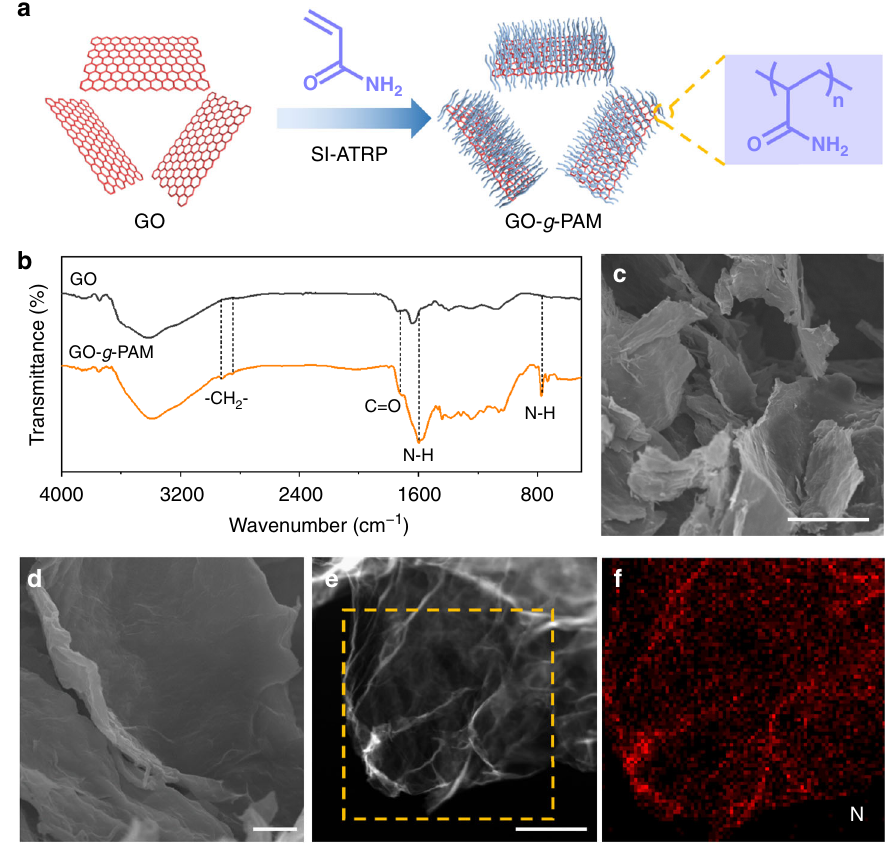
Fig. 2 Characterization of GO- g -PAM molecular brushes. a Schematic illustration of the synthesis of GO- g -PAM molecular brushes: modifying GO nanosheets by α -bromoisobutyryl bromide to introduce Br-containing initiation sites and in situ grafting PAM chains from the modi fi ed surface of GO nanosheets via SI-ATRP. b FTIR spectra of GO and GO- g -PAM. c , d SEM images of GO- g -PAM. e , f Elemental mapping showing the molecular-level homogeneous distribution of N on GO nanosheets. Scale bars: ( c ) 20 μ m, ( d ) 2 μ m, and ( e ) 500